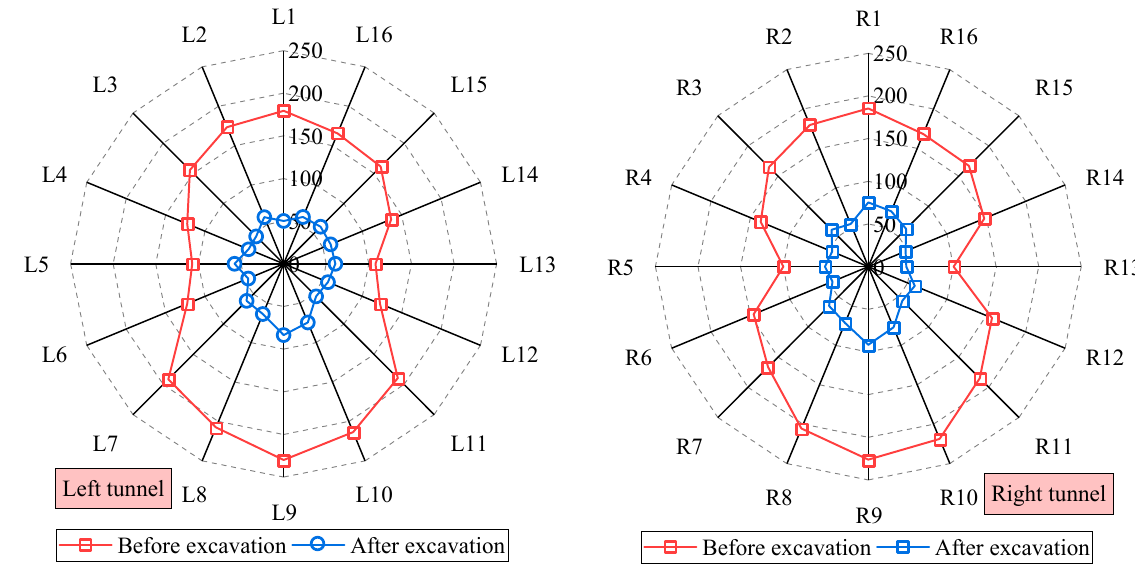
Figure 10. Variations of earth pressure around tunnel before and after excavation (unit: kPa).